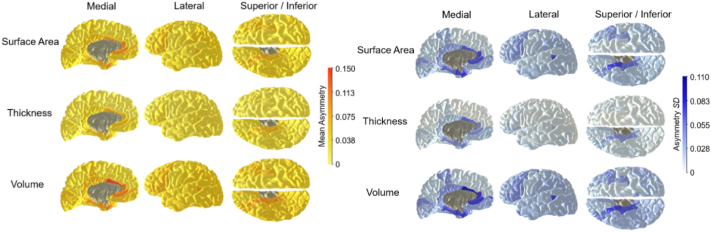
Brain heatmaps illustrating the absolute asymmetry of the 34 cortical regions: Means (left) and standard deviations (right).